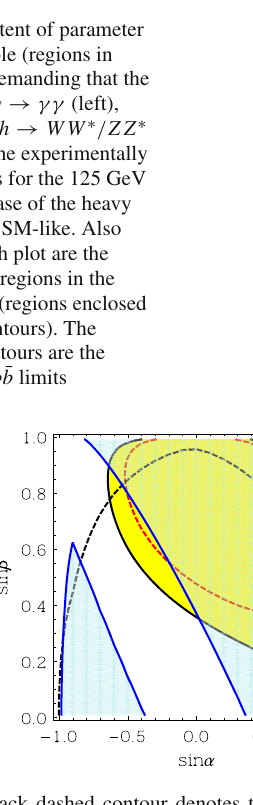
Fig. 9 The black dashed contour denotes the allowed region in the parameter space satisfying the h → τ + τ − data for the case where the heavyHiggsisSM-like.SimilartoFig7,theintersectionregionbetween the black, red-dashed, and black-dashed lines satisfies the Higgs prop- erties measured by the ATLAS and CMS